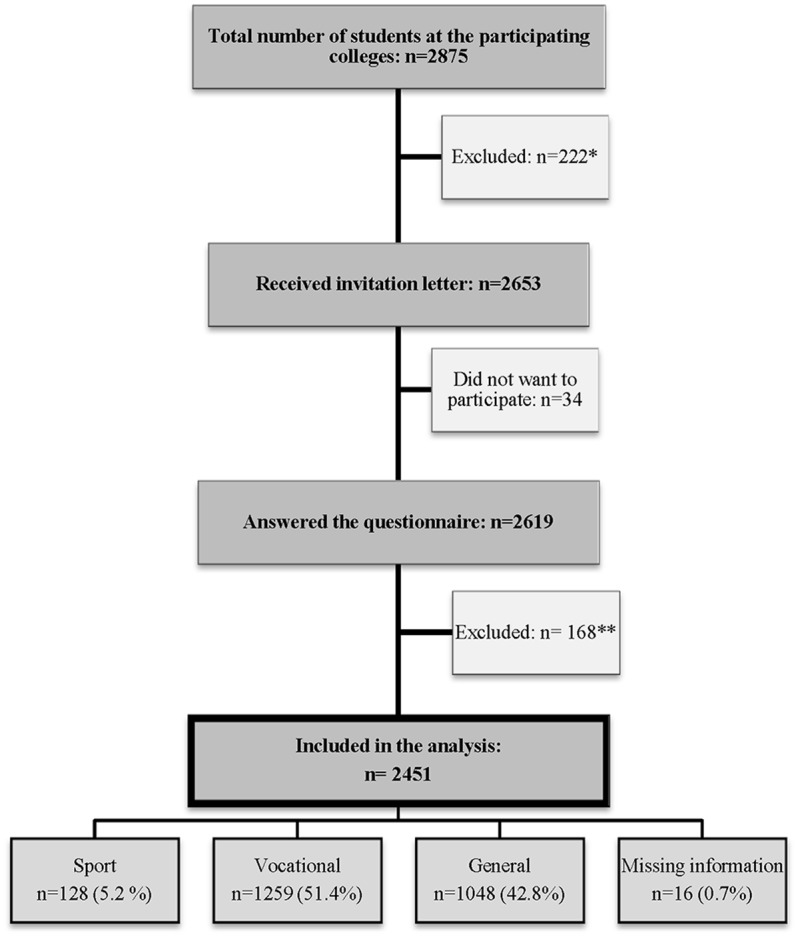
Flowchart showing inclusion and exclusion of participants in the study and classification of the participating sample.*Had dropped out from school, school classes that participated on excursions/project work or absence due to illness, travel or other unknown reasons. **Age >17 years.